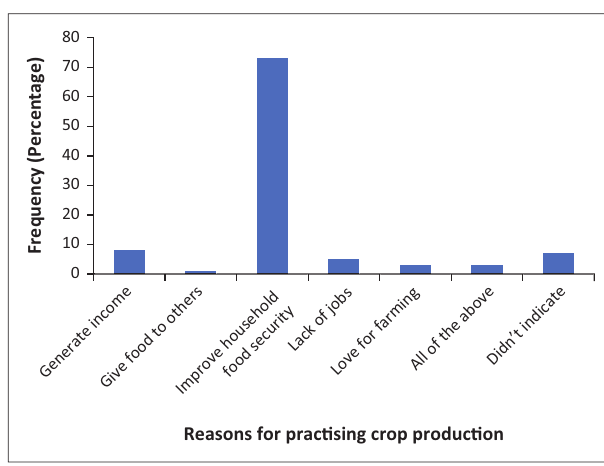
FIGURE 2: Reasons for practising crop production by female farmers in Thaba Chweu Local